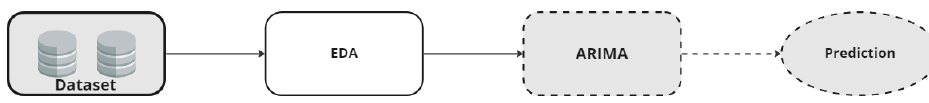
Figure 5. The research